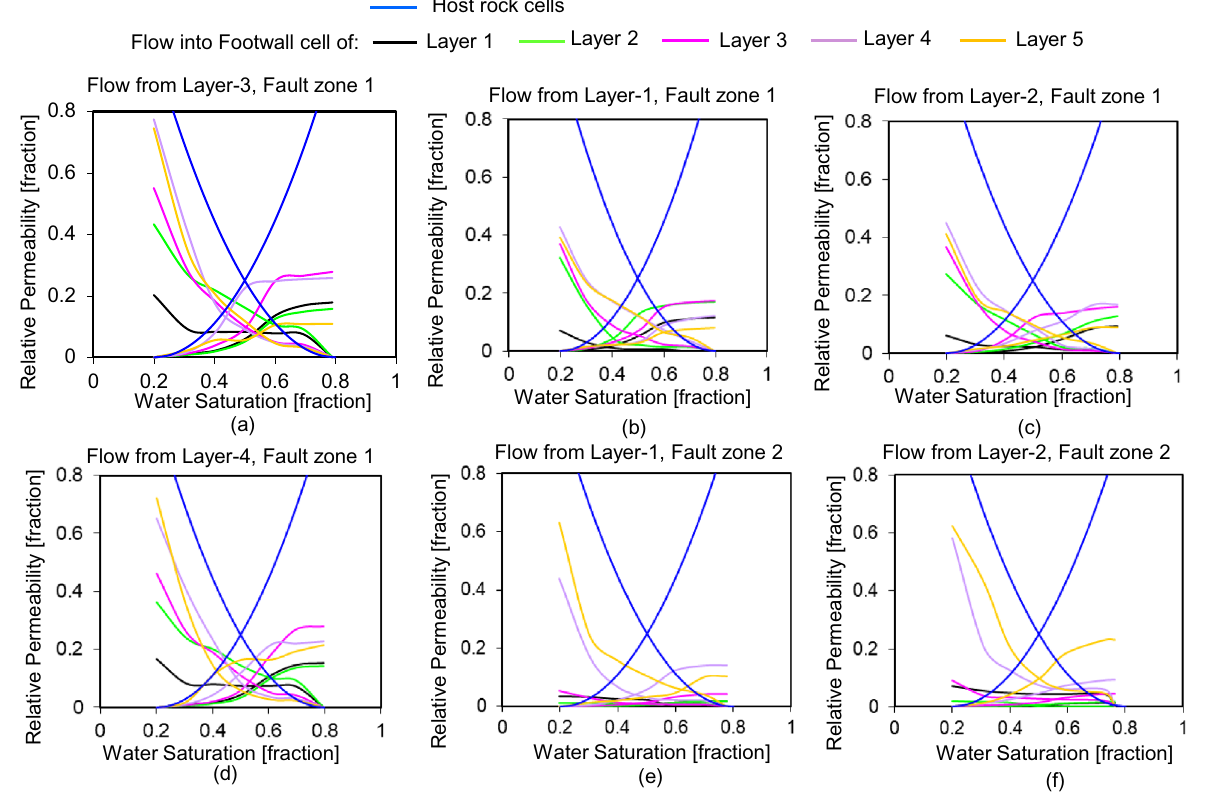
Figure 12. The upscaled pseudo-relative permeability curves. Each graph is associated with flow from the different hanging wall layers indicated, and the different colored curves are for flow into different footwall